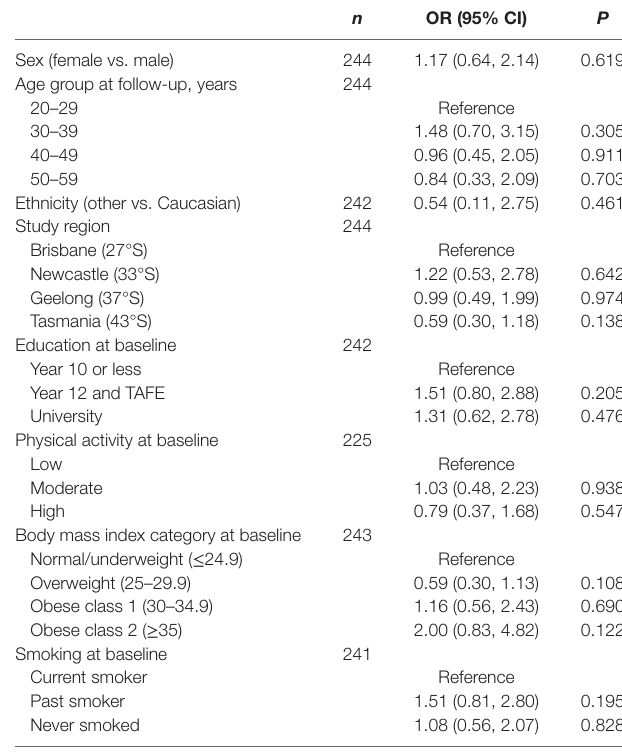
TaBle 2 | Univariate logistic regression models a showing associations between each participant characteristic and odds of making a dietary